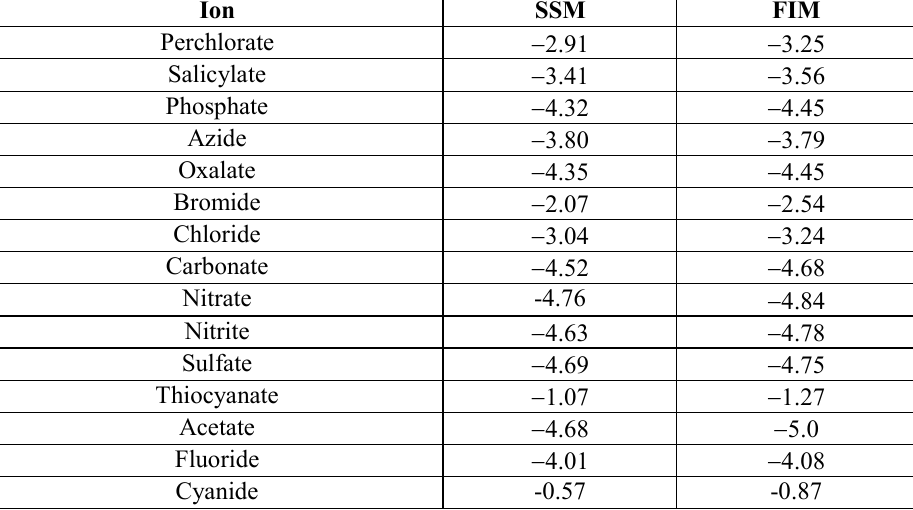
Figure 3. Application of the electrode based on Hg(BPPPB)Cl of (A) 100 mL 1×10  3 M Ag + with 0.1 M I  and (B) 100 mL 1×10  3 M I  with 0.1 M of Ag + . Table 3. Selectivity coefficients of the proposed coated-graphite electrode.